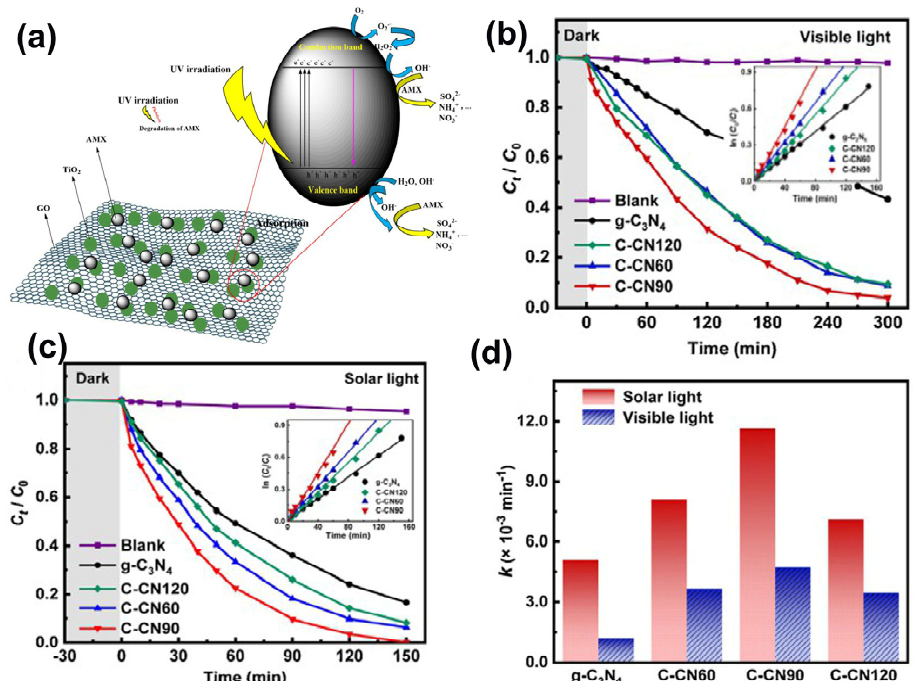
Figure 10. ( a ) Possible mechanism of amoxicillin degradation at GO/TiO 2 surface. (Reproduced with permission from [97], copyright 2021, Springer Nature). Photocatalytic degradation kinetics of amoxicillin by the synthesized materials under ( b ) visible light and ( c ) simulate solar light. ( d ) amoxicillin degradation rate constants under solar and visible light. (Reproduced with permission from [99], copyright 2021, Elsevier).